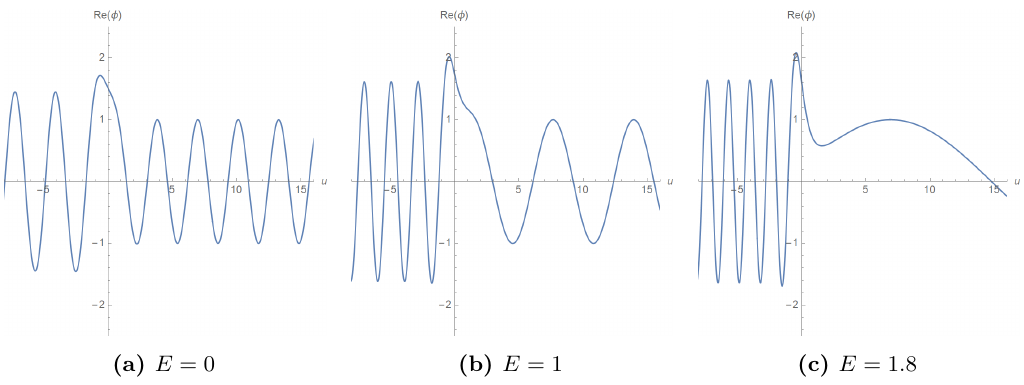
Figure 5. We plot the real part of the charged scalar φ which is outgoing at u = ∞ . The frequency ω = 2 and mass m = 2 are kept fixed, while varying background field E . Increasing E reduces the transmission coefficient (3.22). It increases the momentum of the wave near x = − 1 and decreases it near x = 1 . At ω = E , the wave near x = 1 changes